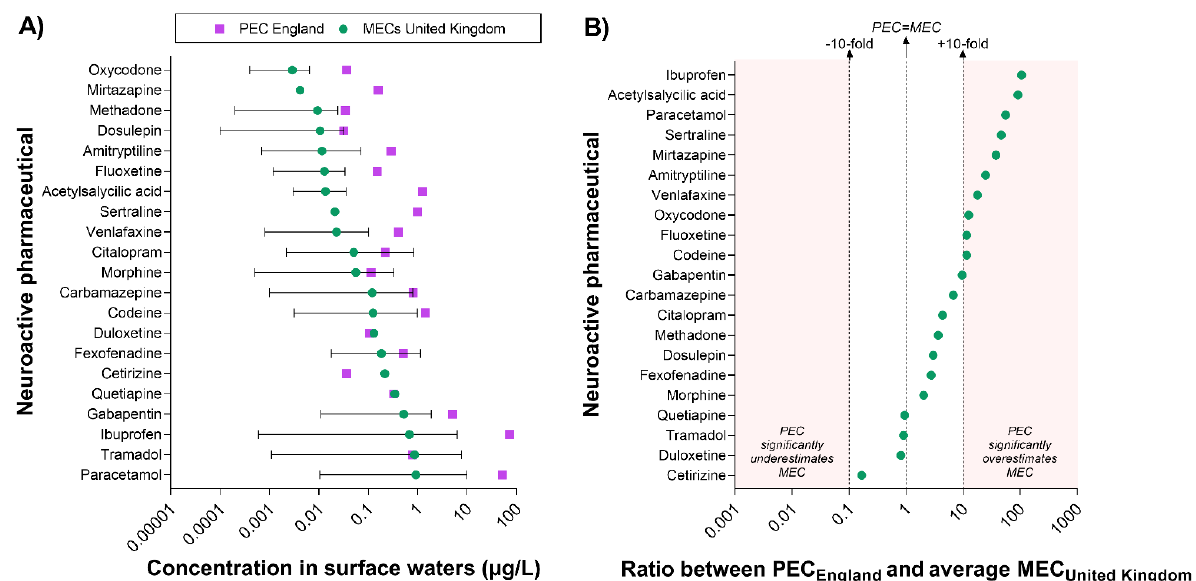
Figure 4. Comparison between predicted and measured concentrations of neuroactive pharmaceuticals in surface waters in the United Kingdom . Measured concentrations of neuroactive pharmaceuticals in UK surface waters (MECs)—extracted from the PHARMS-UBA database—were available for 21 compounds. ( A ) This panel displays the range of UK MECs reported for each compound and their average value (i.e., green dots). It is important to note that the latter is not a “true” average MEC, but only the average of the values available in the database, which include single measurements as well as average, minimum, and maximum values. England-specific PECs are indicated by purple squares. ( B ) This panel displays the ratio between PEC England and the average MEC United Kingdom and provides an estimation of the discrepancy between predicted and measured values. To facilitate the interpretation of the data, the vertical dotted lines indicate the level of maximum accuracy (i.e., Ratio PEC/MEC = 1) and the +10-fold and − 10-fold range. The red areas indicate when a PEC value overestimates or underestimates the average MEC by more than